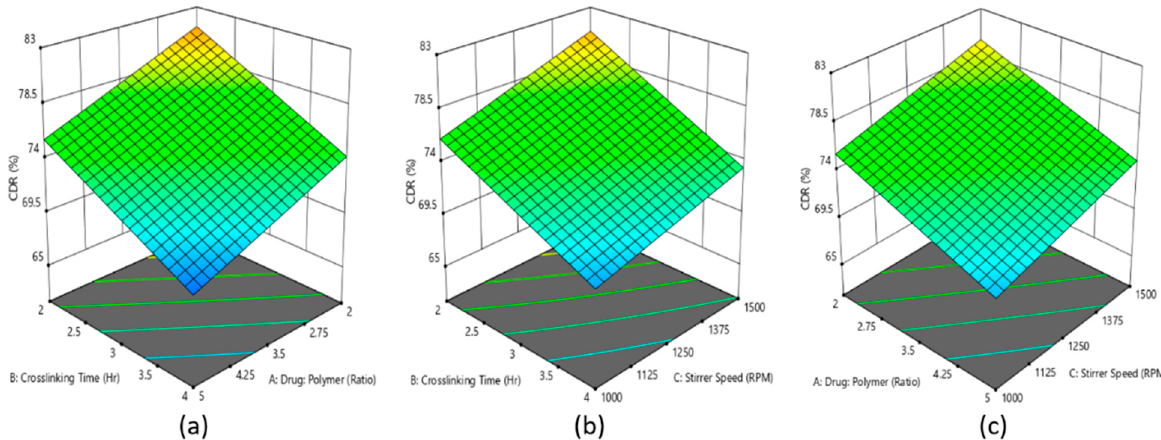
Figure 1. Effect of the interaction of ( a ) drug–polymer ratio, ( b ) crosslinking time, and ( c ) stirring speed is represented in the 3D surface plot on percentage of drug released from rivastigmine nanoparticle formulation.